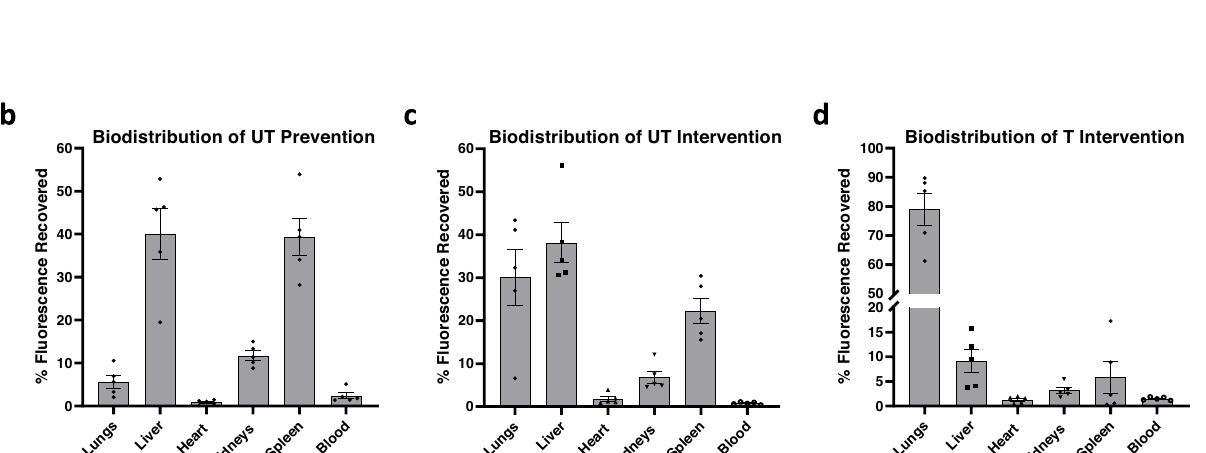
fromallorgans)formicereceiving( b )UTprevention,( c )UTintervention,and( d )T intervention treatments. Experimental groups consist of N =5 mice per group. Circles represent individual data points, bar graph represents the average of indi- vidual data points, and error bars represent standard error. Source data are pro- vided as a Source Data fi